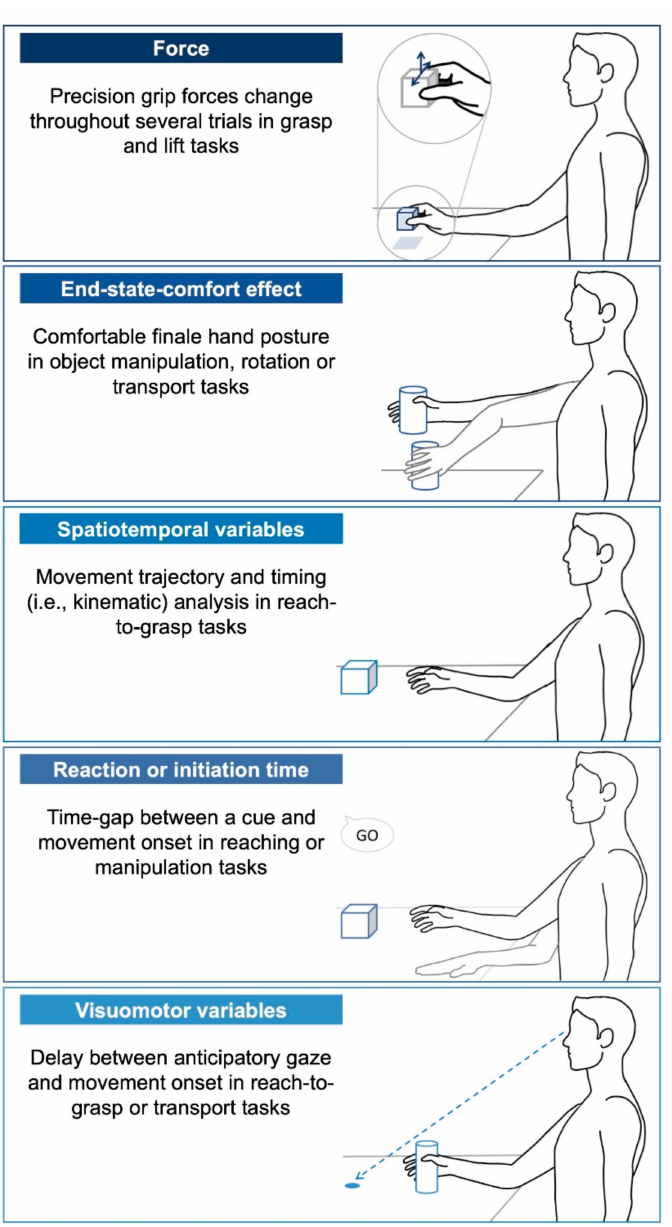
Figure 1. Motor planning variables found among the selected